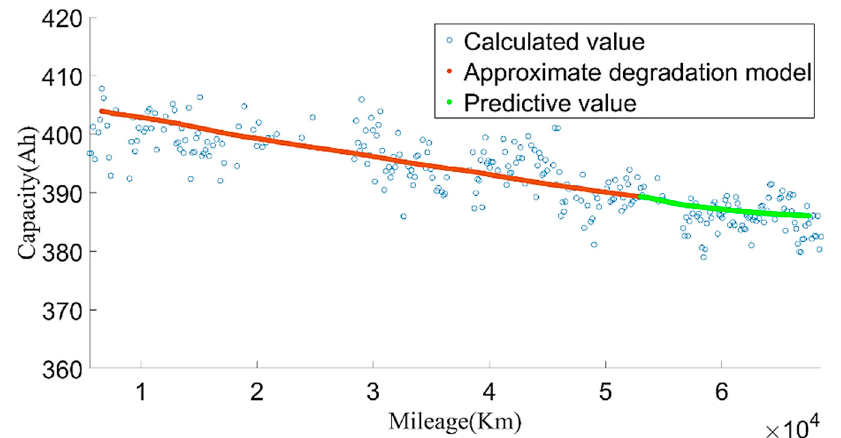
Figure 29. The SOH prediction results based on LSTM.